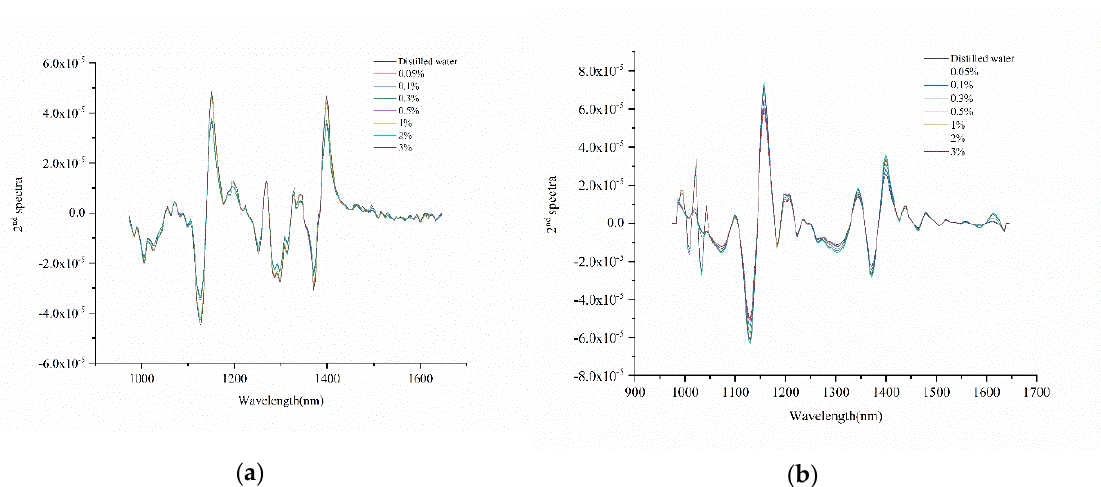
Figure 4. Spectral curve processed by Savitzky–Golay: ( a ) portable NIR spectrometer and ( b ) NIR-HSI system. Table 3. The important wavelengths recognized by Savitzky–Golay.